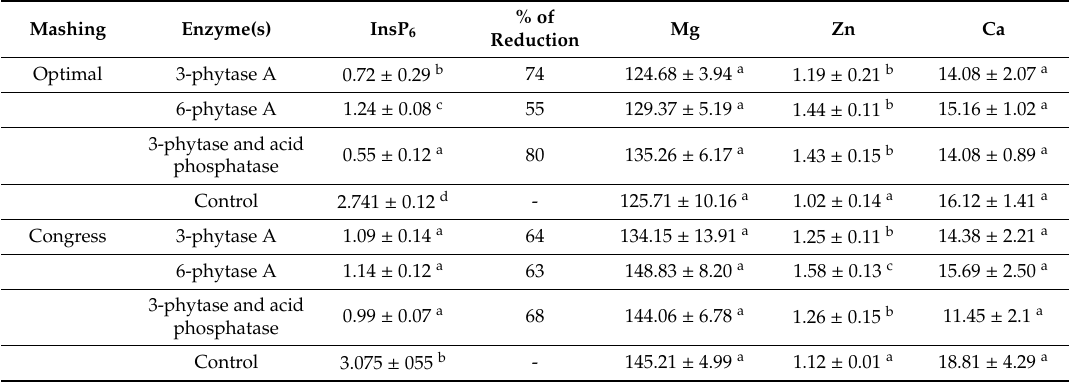
Table 2. Phytate (mg / g malt) contents and selected mineral elements availability ( µ g / mL) in buckwheat wort supplemented with